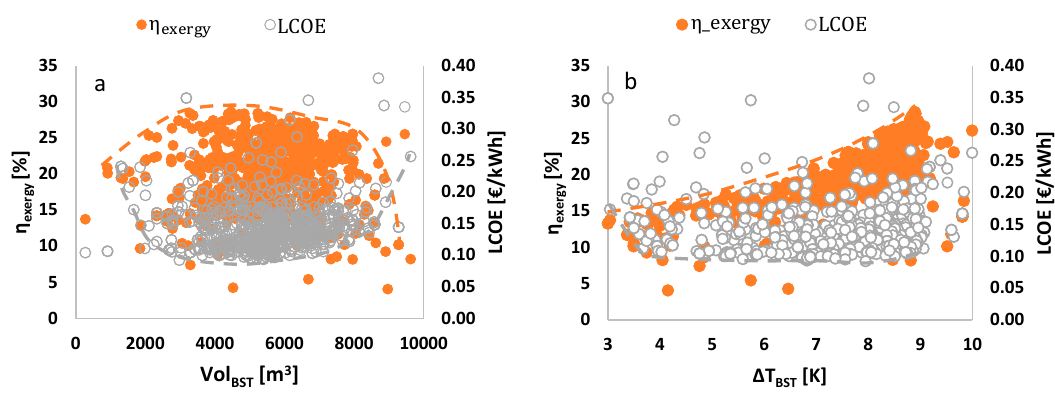
Figure 11. Local search for finding optimum ranges of ( a ) Vol BTES and ( b ) ∆ T BST of ActSer scenario. Table 7. The economic, the compromise and the e ffi cient system designs of each